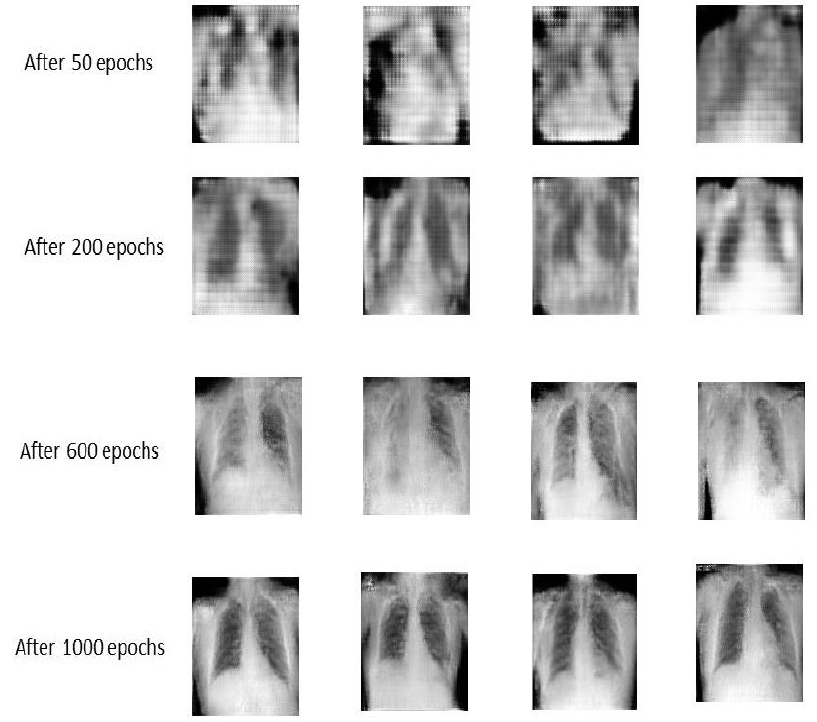
Figure 5. Generator learning process.